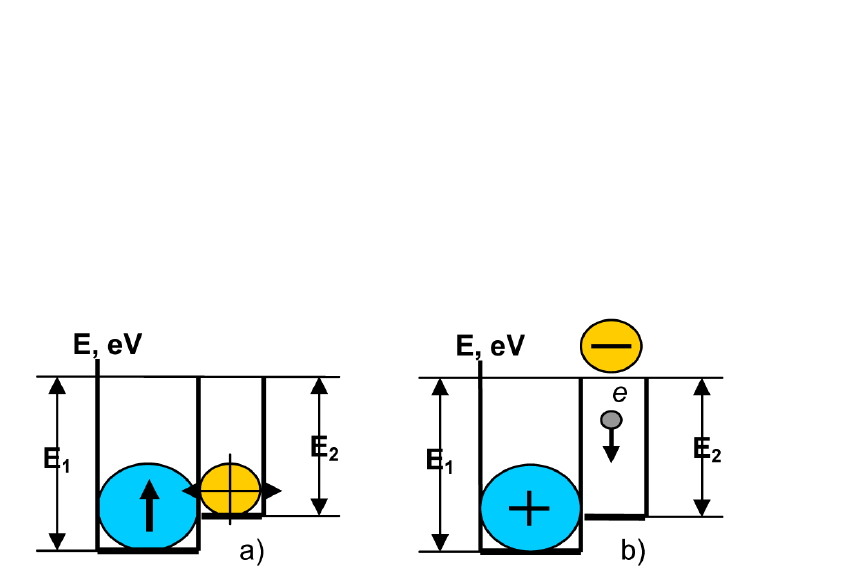
Figure 1 – Scheme of the negative ions generation in the cluster explosion process: a) – model of the cluster atoms interaction with the substrate and b) – model of the electrical charge separation during vapor ejection after a cluster explosion Рис . 1 – Схема образования отрицательных ионов в процессе взрыва кластера